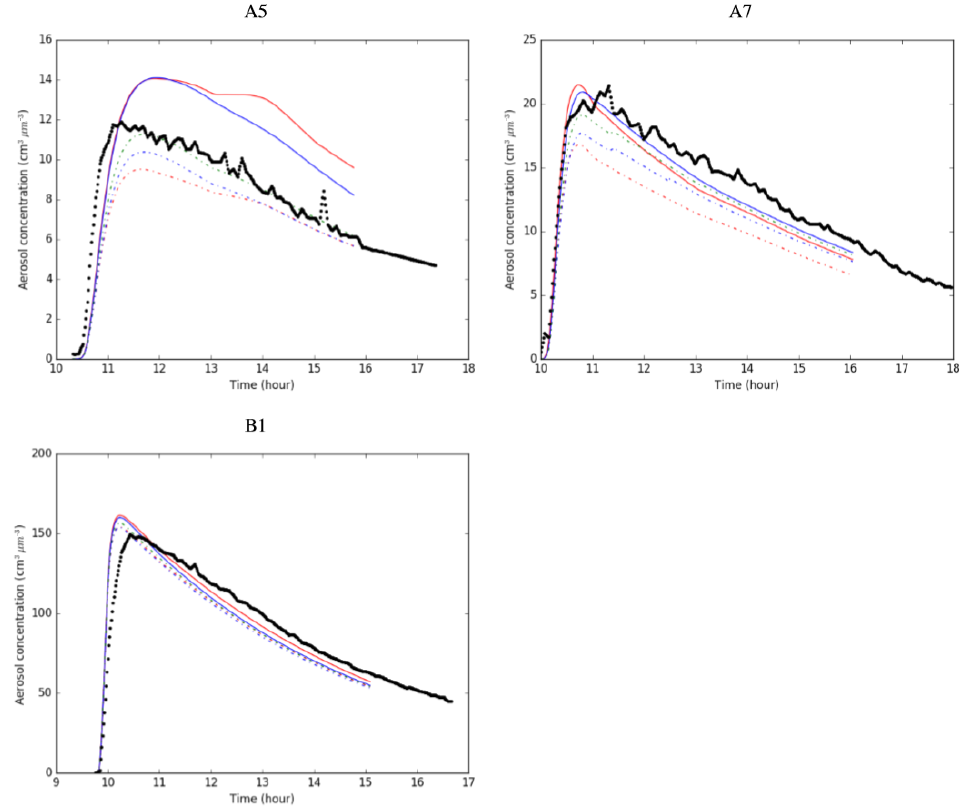
Figure 10. Effect of viscosity and gas wall losses on SOA concentrations for several experiments. The black line corresponds to SMPS measurements, the red lines correspond to modeled SOA concentrations for the non-viscous aerosol assumption, the blue lines correspond to modeled SOA concentrations for the viscous aerosol assumption and the green line corresponds to modeled SOA concentrations for the viscous aerosol assumption with a decrease by 20% of volatilities. Solid lines correspond to simulations assuming no gas wall losses, and dotted lines correspond to those assuming gas wall